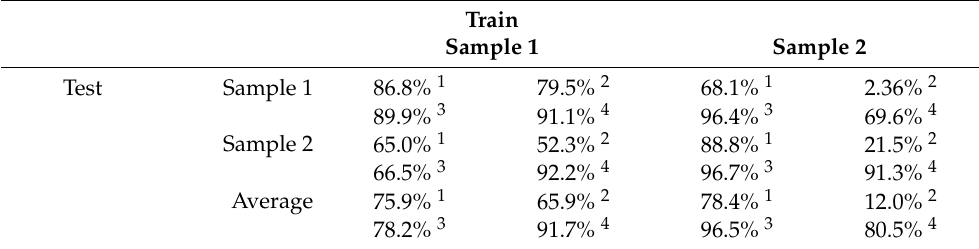
Table 7. CNN performance on all samples.